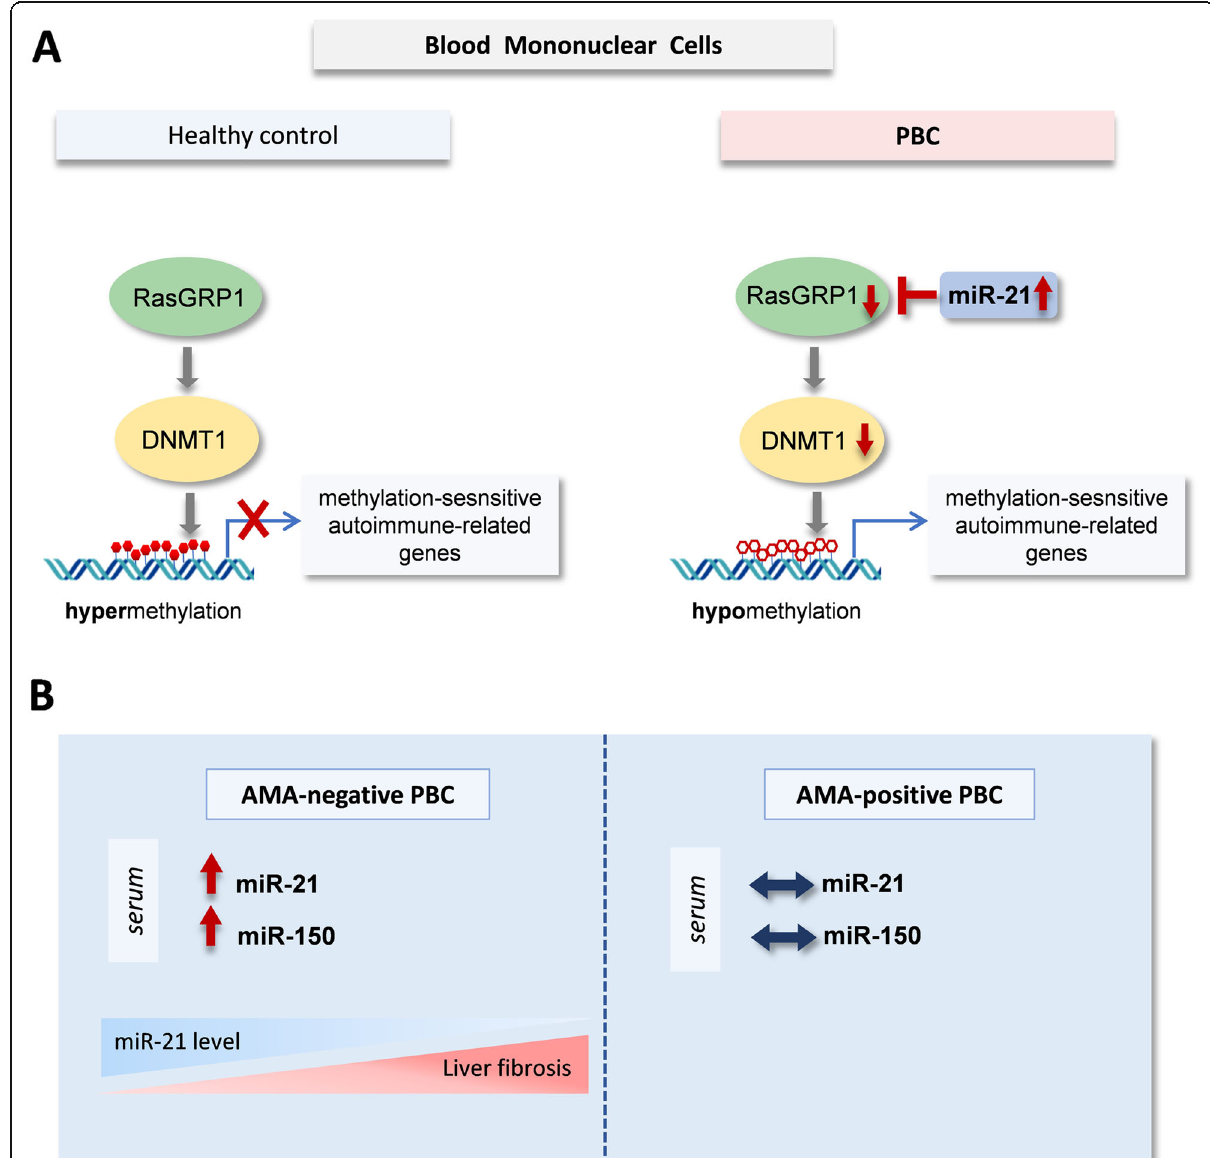
Fig. 5 a. The increased level of miR-21 in PBMCs leads to the downregulation of RASGRP1 mRNA with the concomitant decrease of DNMT1, triggering immune-driven progression of PBC. b. AMA- negative PBC patients are characterized by enhanced expression of miR-21 and miR-150. The elevated levels of serum miR-21 in AMA- negative PBC decreases gradually as liver fibrosis